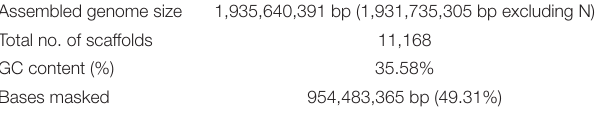
TABLE 2 | Repeat profile in assembled P. indicus